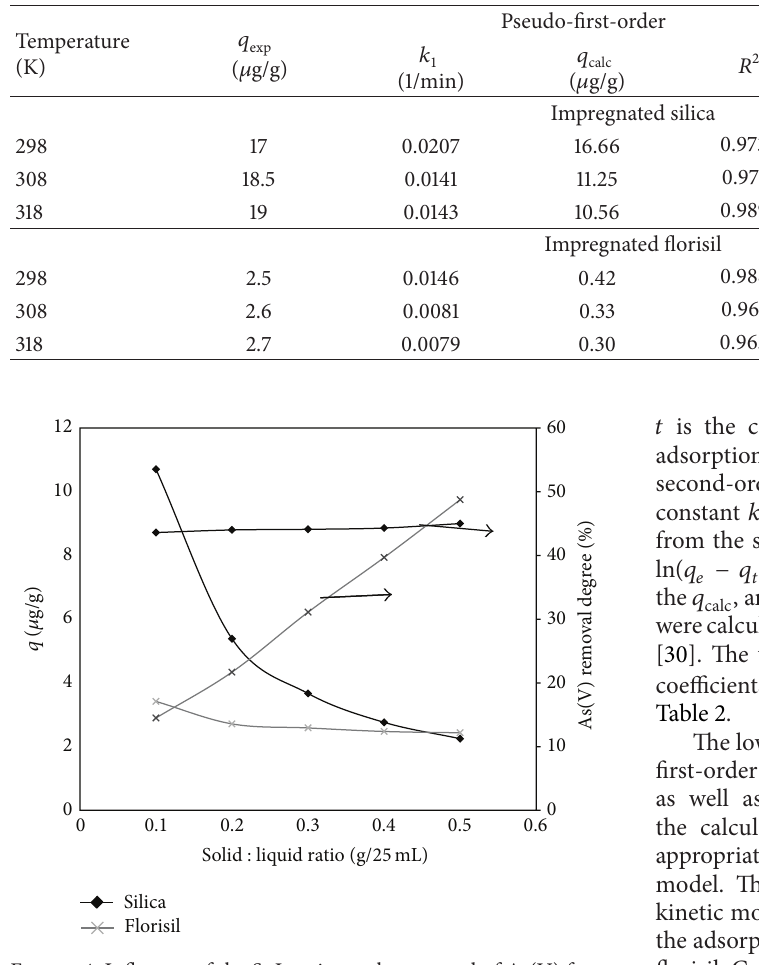
Figure 4: Influence of the S :L ratio on the removal of As(V) from aqueous solutions for impregnated silica and